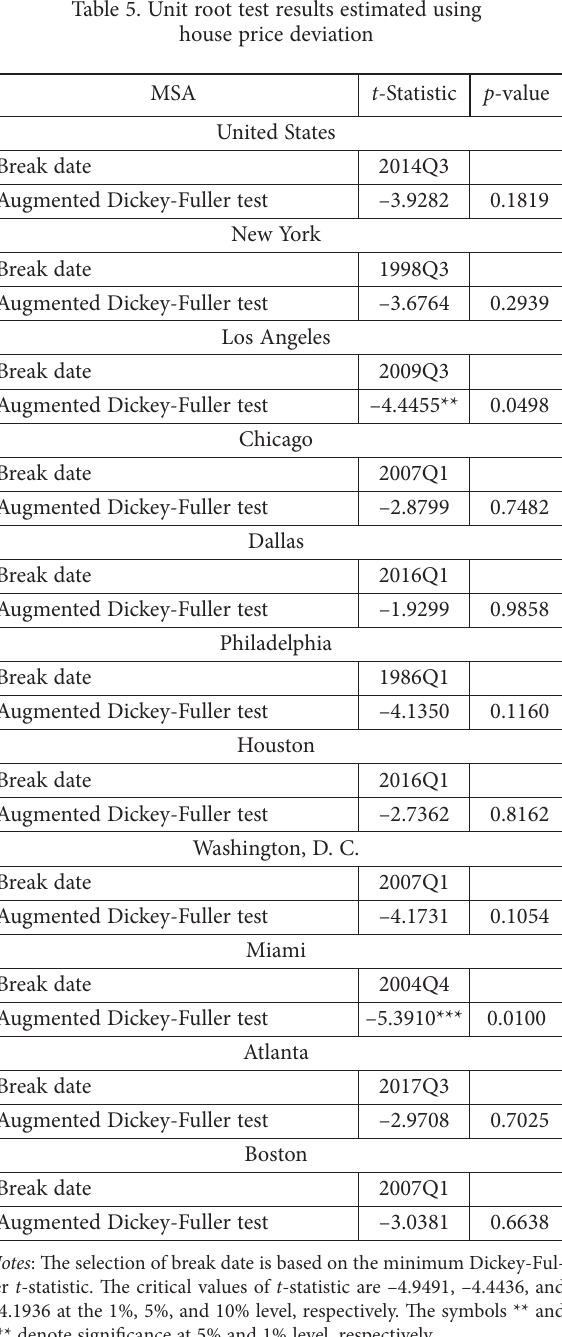
Table 5. Unit root test results estimated using